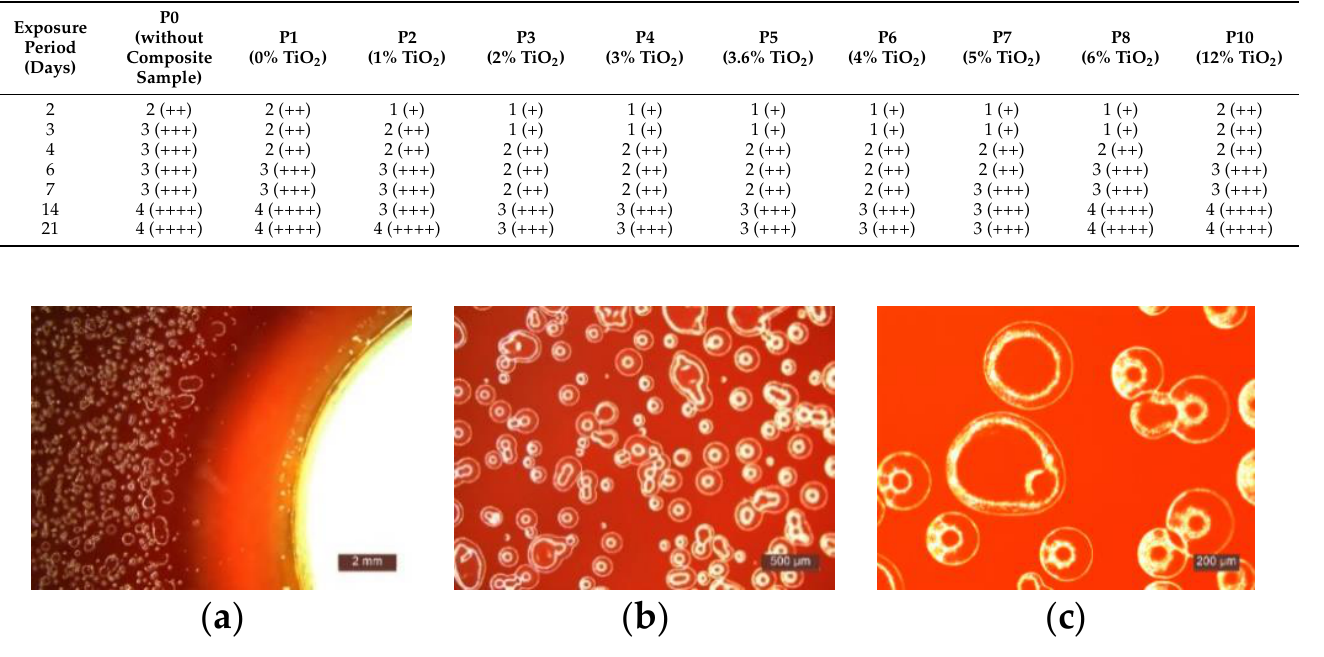
Figure 6. Microscopic examination of the behavior of samples exposed to Streptococcus Pyogenes : ( a ) Identification of the inhibition halo area (1:2 mm); ( b ) Growth of colonies (1:500 µ m); ( c ) Detail growth of colonies (1:200 µ m). Table 6. Quantification of the microbiological load of the system according to STAS 12718 for samples exposed to Strepto- coccus Pyogenes .